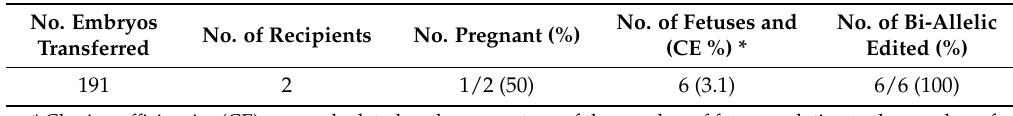
Table 2. Generation of clustered regularly interspaced short palindromic repeat and associated nuclease Cas9 (CRISPR/Cas9)-mediated GRB10 targeted cloned fetuses.